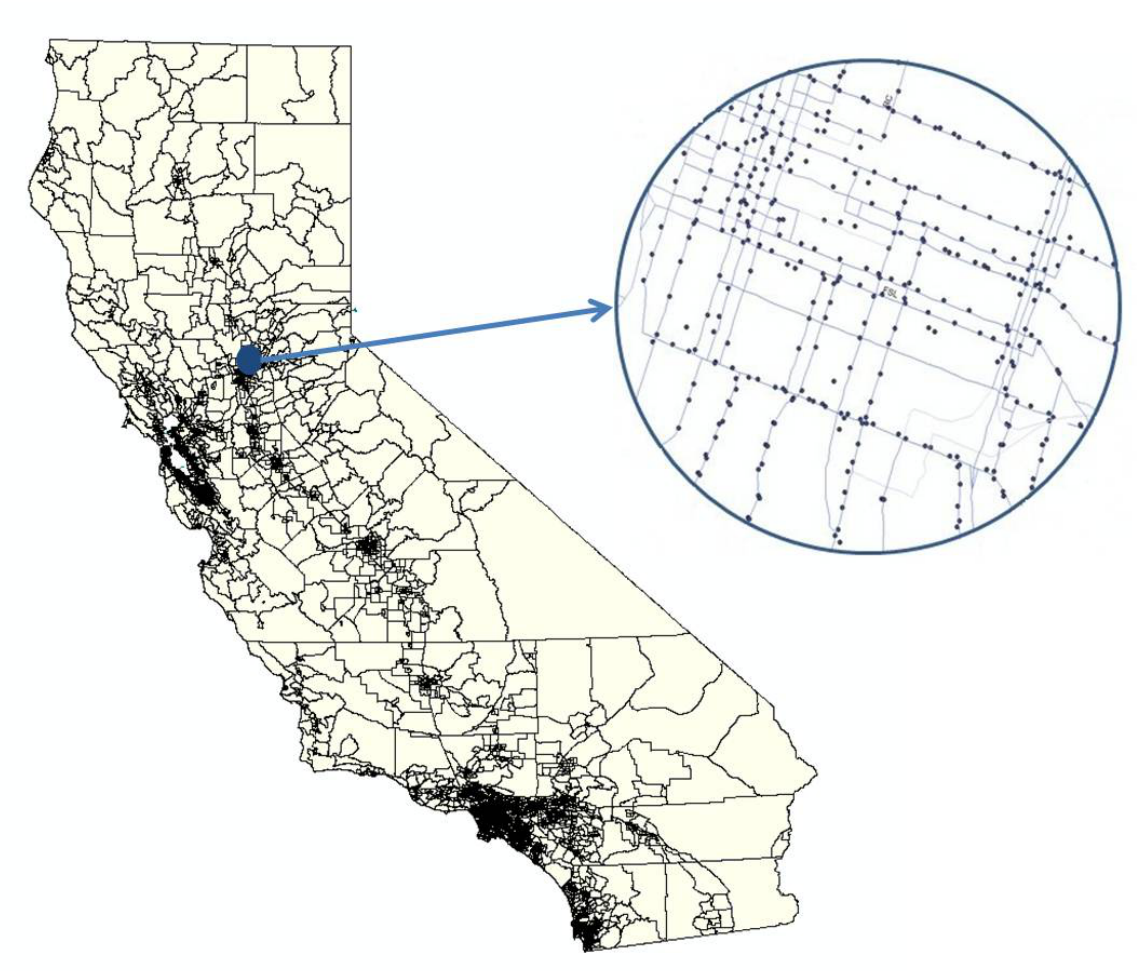
Figure 1. Distribution of local public transportation services in California. The right part of the figure shows an enlarged map of the local bus lines and stops in downtown